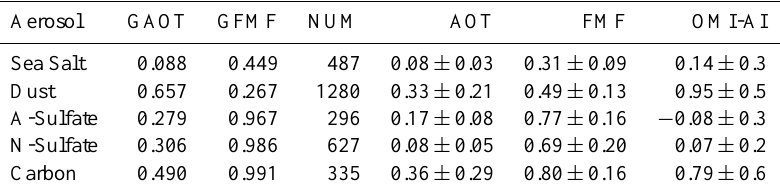
Table 2. Yearly averaged GOCART AOT and FMF (GAOT, GFMF); sample size, AOT and FMF (AOT, FMF), and OMI-AI for sea-salt, dust, sulfates, and organic+black carbon between June 2006 and May 2007 for the Aqua CERES-SSF dataset. Aerosol GAOT GFMF NUM AOT